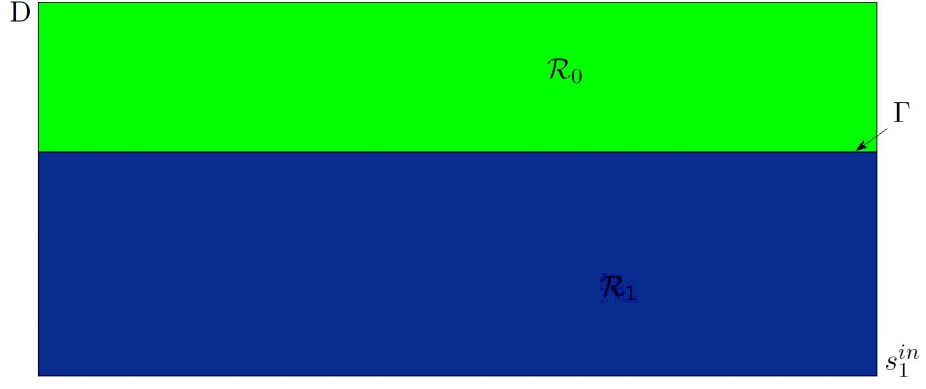
Figure 2. Operating diagram of System (5).